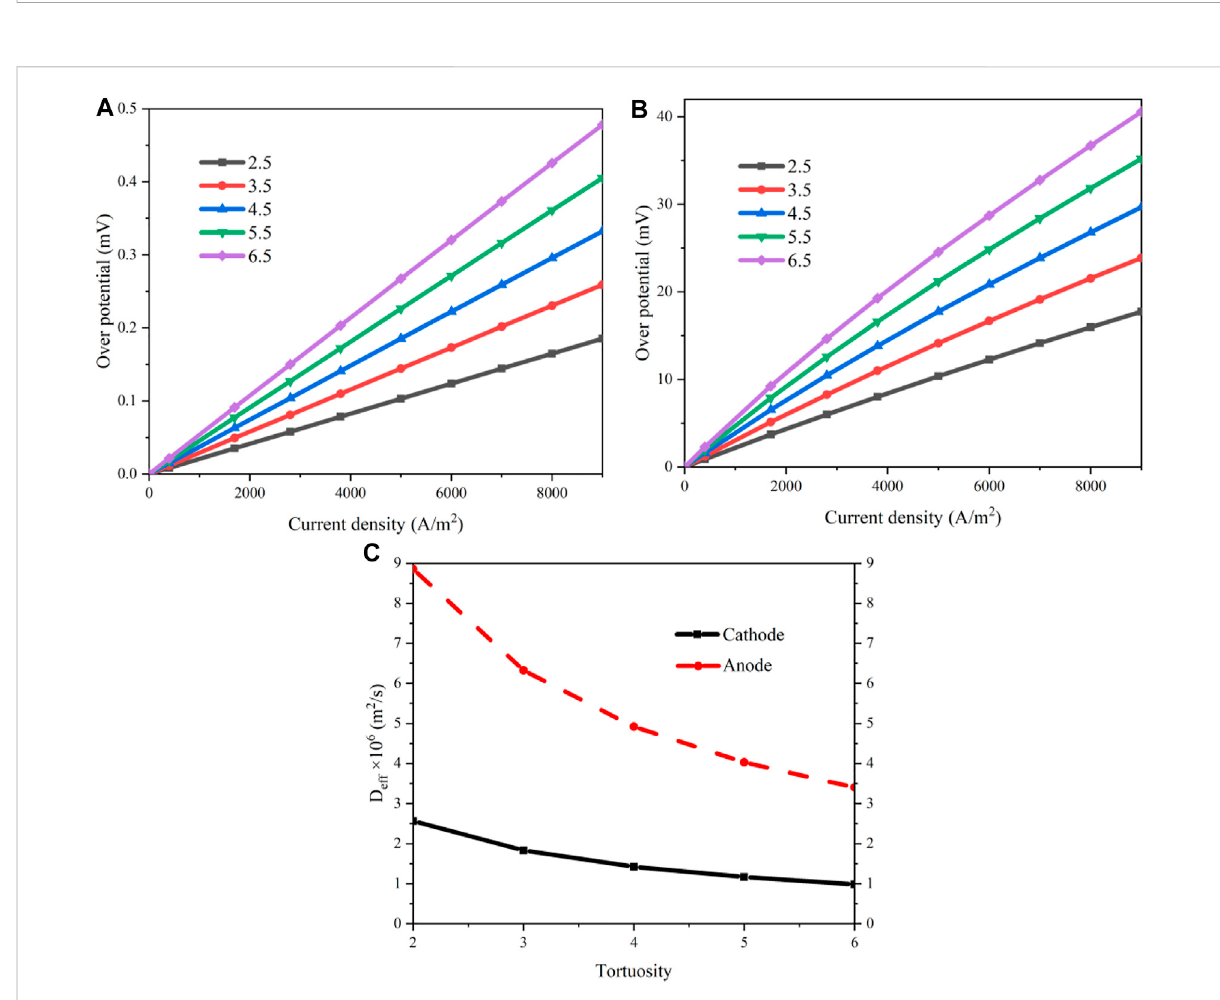
FIGURE 7 Resultsoftheconcentrationlossesasafunctionofthetortuosity: (A) concentrationoverpotentialoftheanode; (B) concentrationoverpotential of the cathode; (C) effective diffusion coef fi cients of the